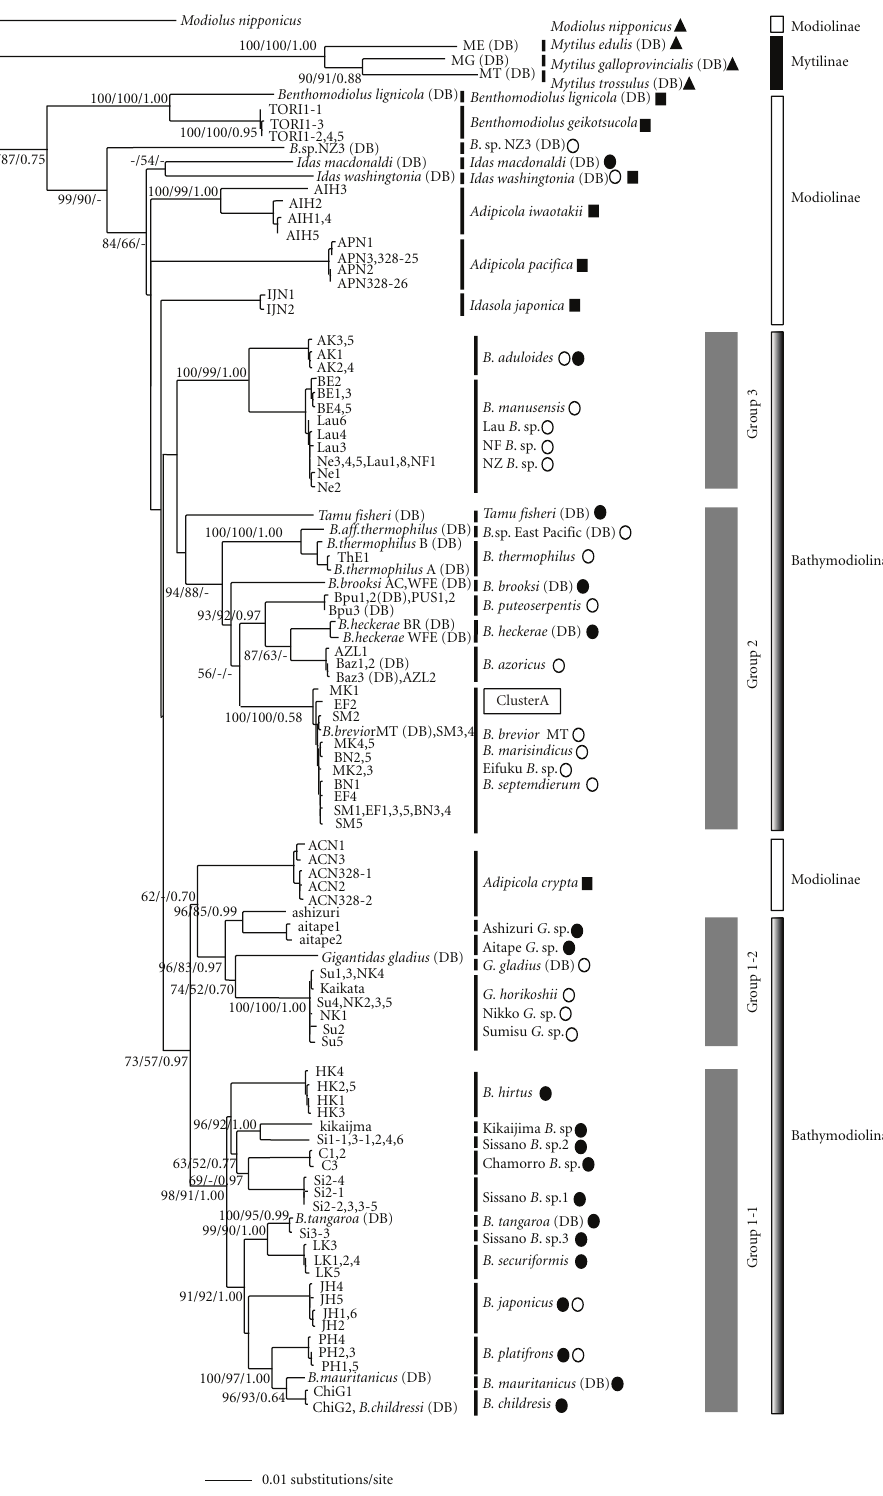
Figure 2: The phylogenetic relationships of the deep-sea Bathymodiolus mussels and their relatives based on the 423-bp mitochondrial ND4 sequences. The NJ tree was constructed based on the genetic distances calculated according to Kimura’s two-parameter method using Modiolus nipponicus as an outgroup species. The MP and Bayesian trees presented essentially the same topology as the NJ tree. Only the NJ (left) and MP (middle) bootstrap values > 50% and Bayesian posterior probabilities (right) > 0.50 are specified. The scale bar indicates 0.01 substitutions per site. See Table 1 for abbreviations of Bathymodiolus mussels and their relatives. (cid:6) , hydrothermal